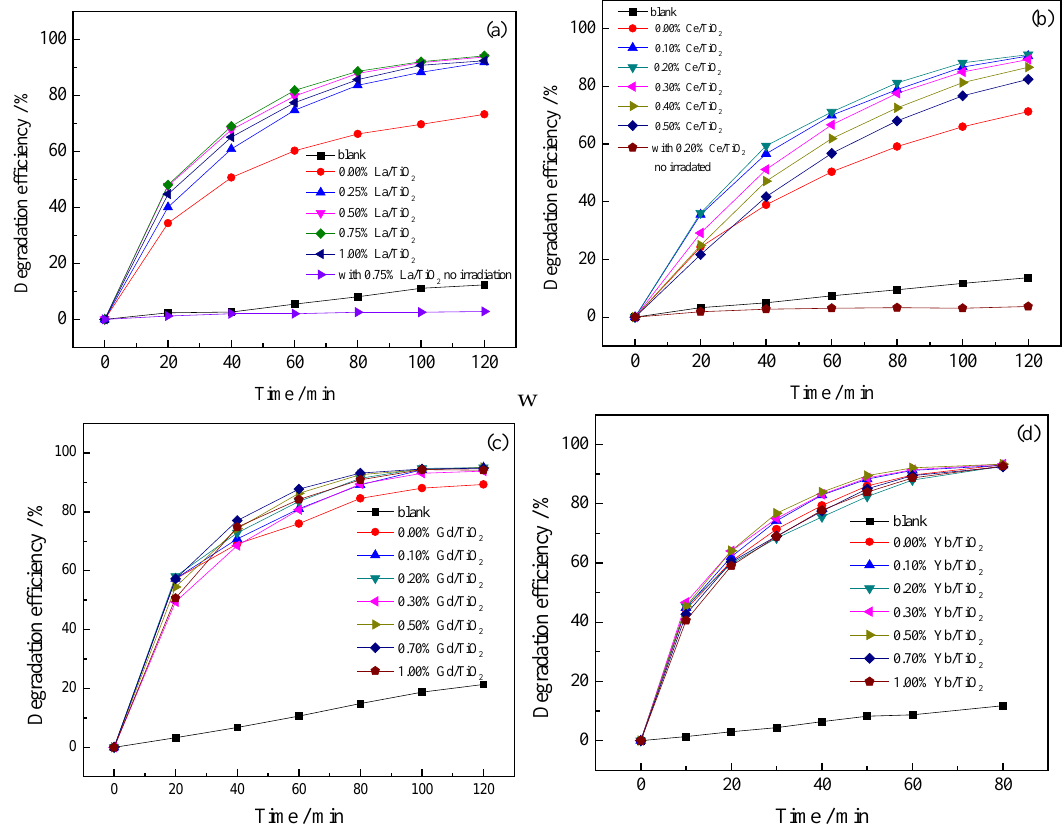
Figure 7. Effects of doping amount of RE/TiO 2 on the photodegradation of benzohydroxamic acid (BHA). ( a ) La/TiO 2 (500 °C); ( b ) Ce/TiO 2 (500 °C); ( c ) Gd/TiO 2 (500 °C); ( d ) Yb/TiO 2 (450 °C).